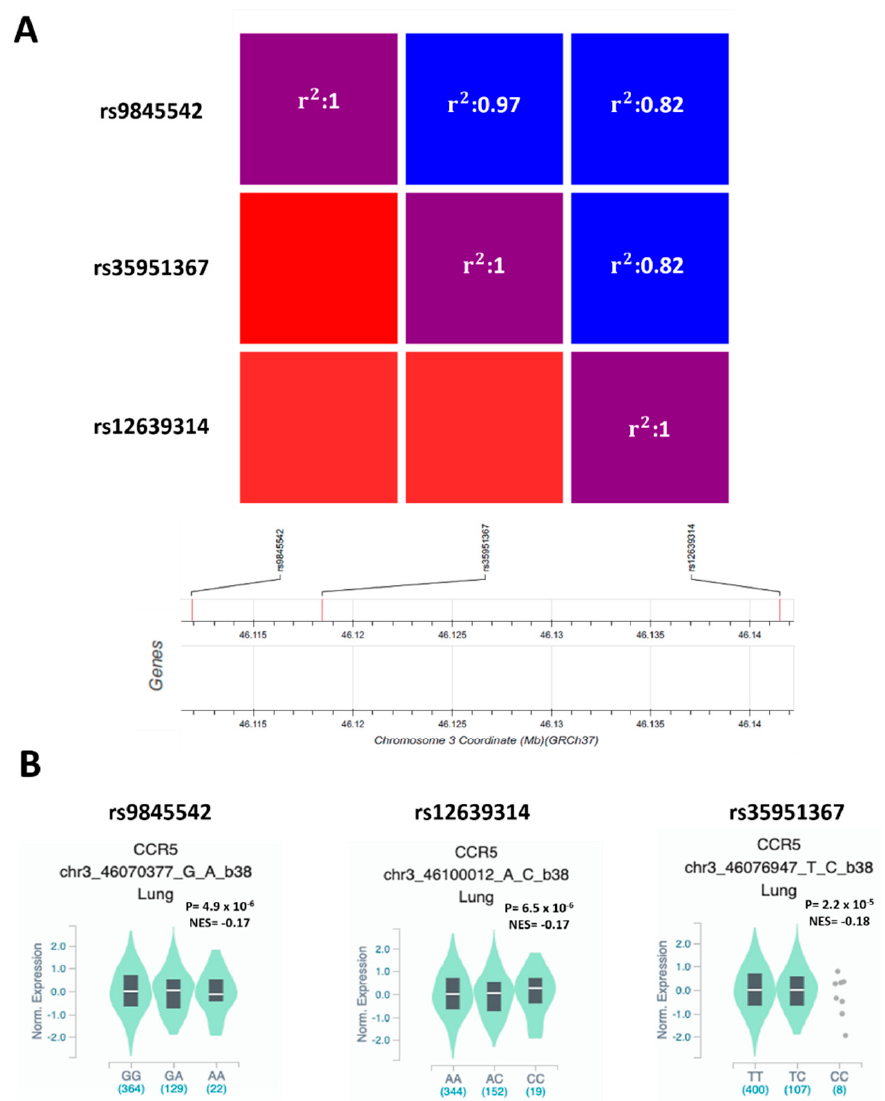
Figure 2. rs9845542, rs12639314, and rs35951367 SNPs are in LD in the European population, and all the minor alleles are associated with low expression of CCR5 in lung. ( A ) Heatmap shows LD among the selected SNPs in the European population. ( B ) Violin plot showing the effect of eQTLs SNPs on CCR5 expression in lung. NES: normalized effect size.